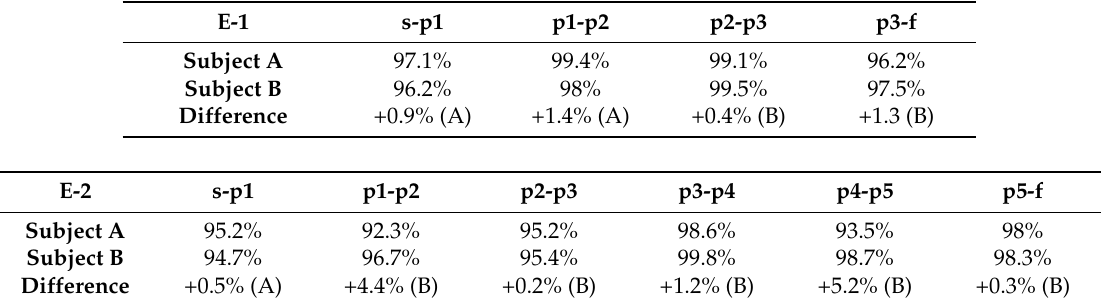
Table 3. Path efficiencies for the two navigation